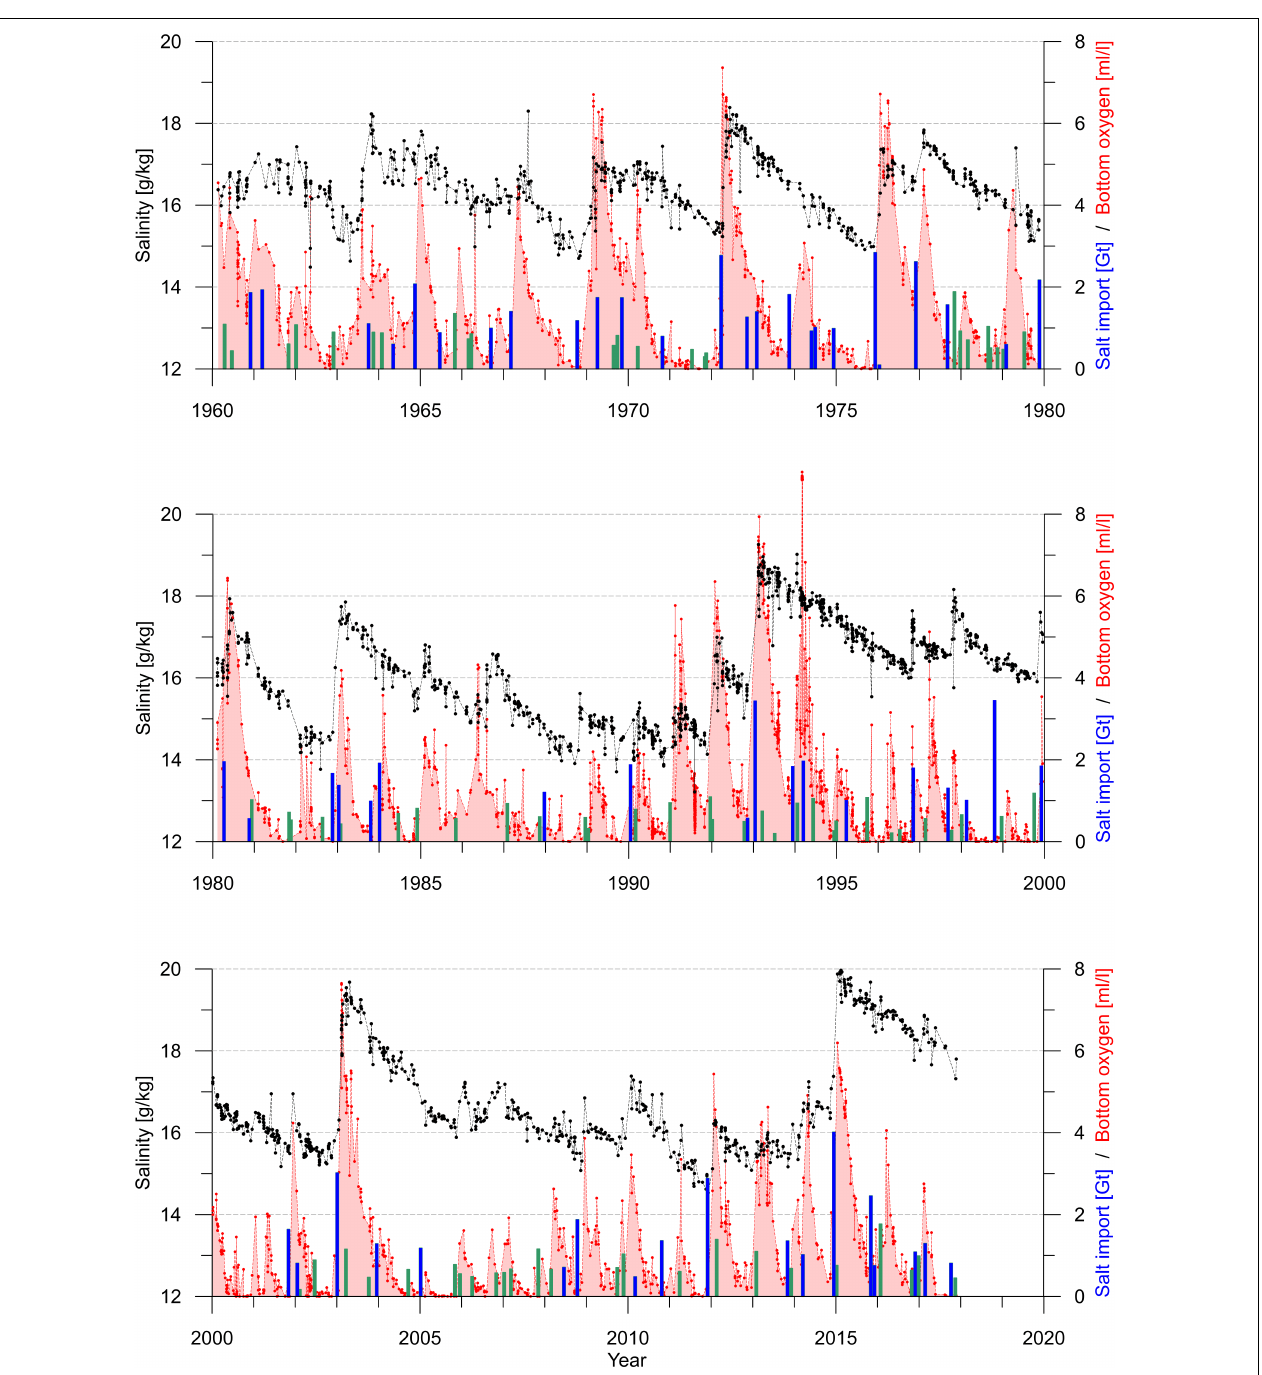
FIGURE 8 | Time series of near bottom salinity (black) and oxygen concentration (red) in the Bornholm Deep (85–90 m), overlaid with barotropic inflow events of the subsets DS5 (blue bars) and DS1 (green bars).